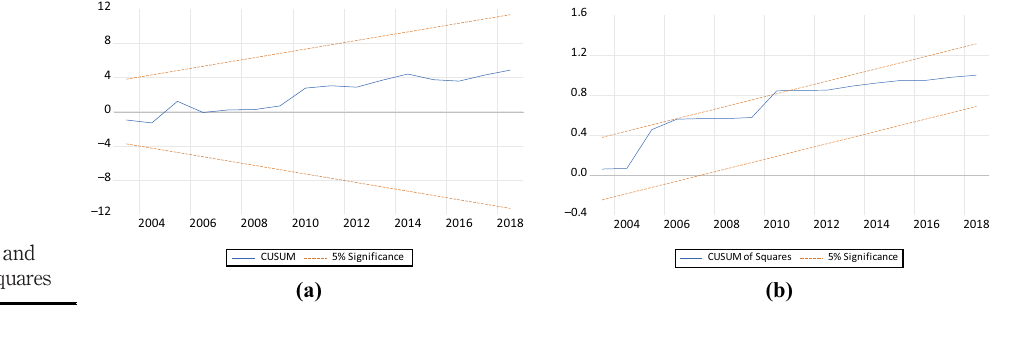
Figure 2. The CUSUM and CUSUM of